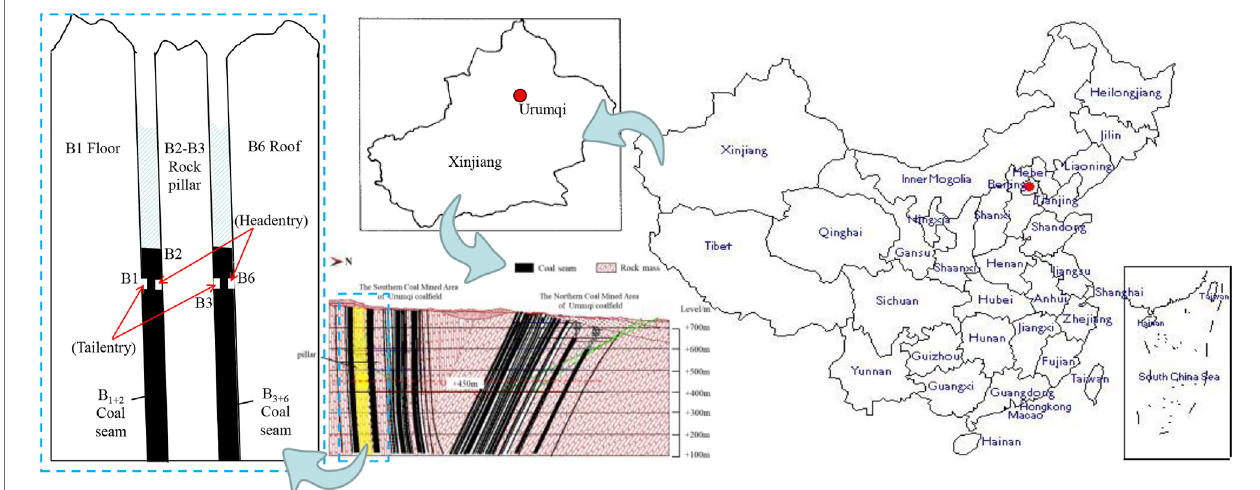
FIGURE 1 | Distribution and geological pro fi le of northern and southern mining areas in the Urumqi mining area.